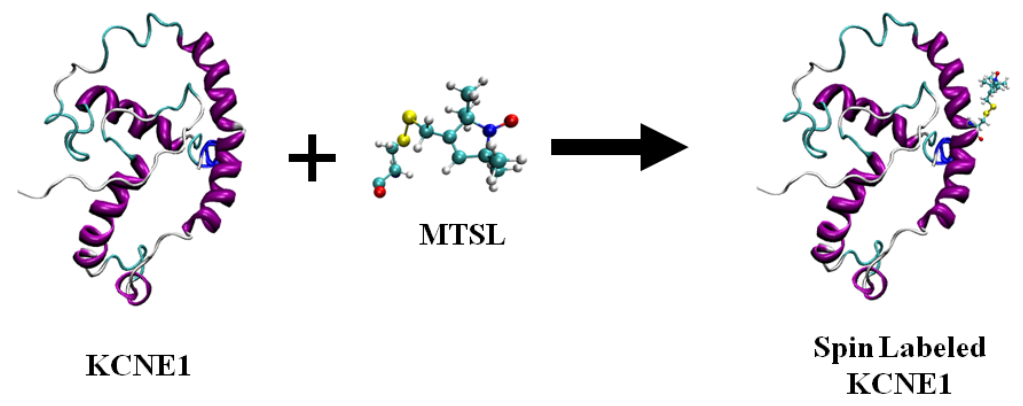
Figure 3. A cartoon representation of the structure of MTSL (methanethiosulfonate spin label) and the resulting side-chain produced by reaction with a cysteine residue (T58C) on a KCNE1 membrane protein. The cartoon structure of the MTSL-labeled KCNE1 (PDB ID:2k21) was rendered using visual molecular dynamics (VMD) [52,53].